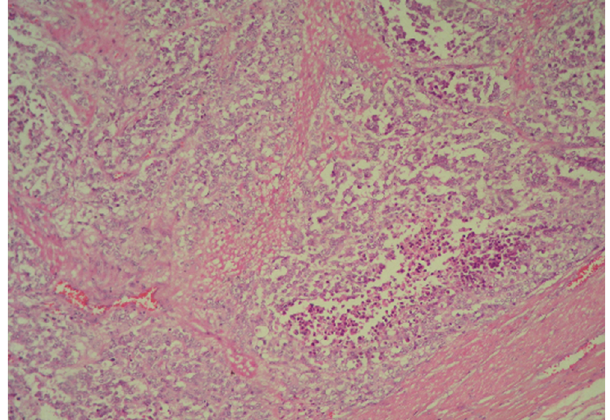
Figure 3 - Anal melanoma. Cross-section of the external surface region (H&E 6 100).